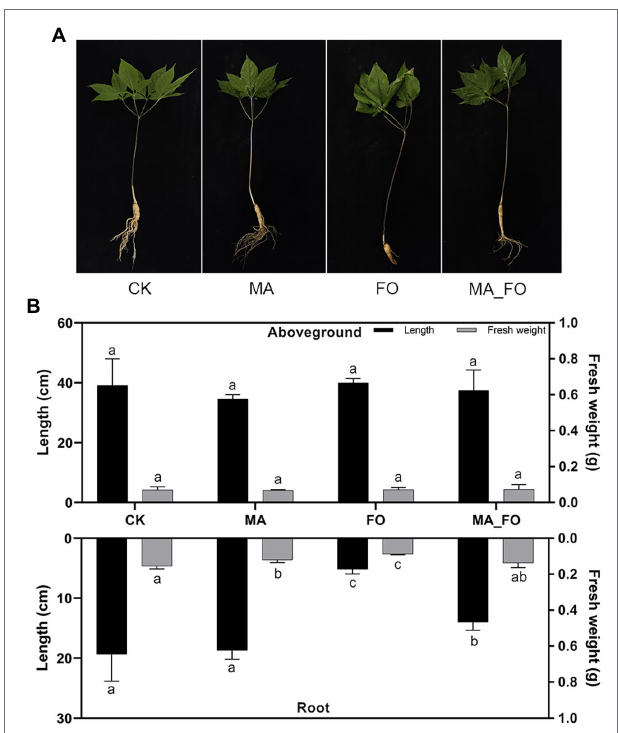
FIGURE 3 | Growth status of ginseng under different inoculation treatments. (A) Photos of ginseng under different inoculation treatments. (B) The length and fresh weight of different parts of ginseng under different inoculation treatments. CK: control, FO: Fusarium oxysporum YFW32, MA: Mortierella alpina YW25, MA_FO: Mortierella alpina YW25 and Fusarium oxysporum YFW32, the same as below. The length and fresh weight of aboveground and root of ginseng under different treatments were analyzed for difference significance separately, and different lowercase letters indicated significant difference ( p < 0.05).